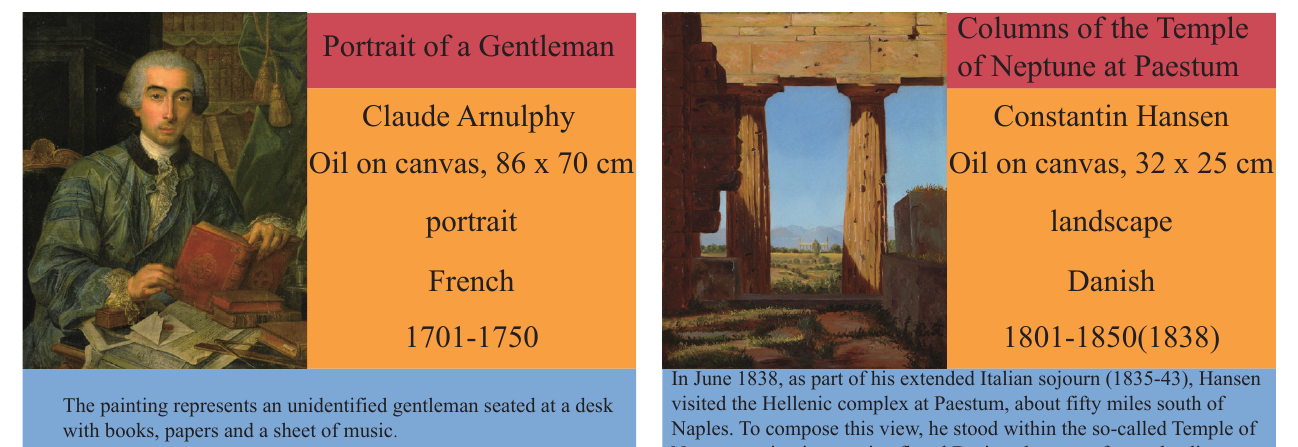
Figure 1. SemArt dataset. Each record includes a title (red), the author, technique and format, school, timeframe (yellow) and artistic comments